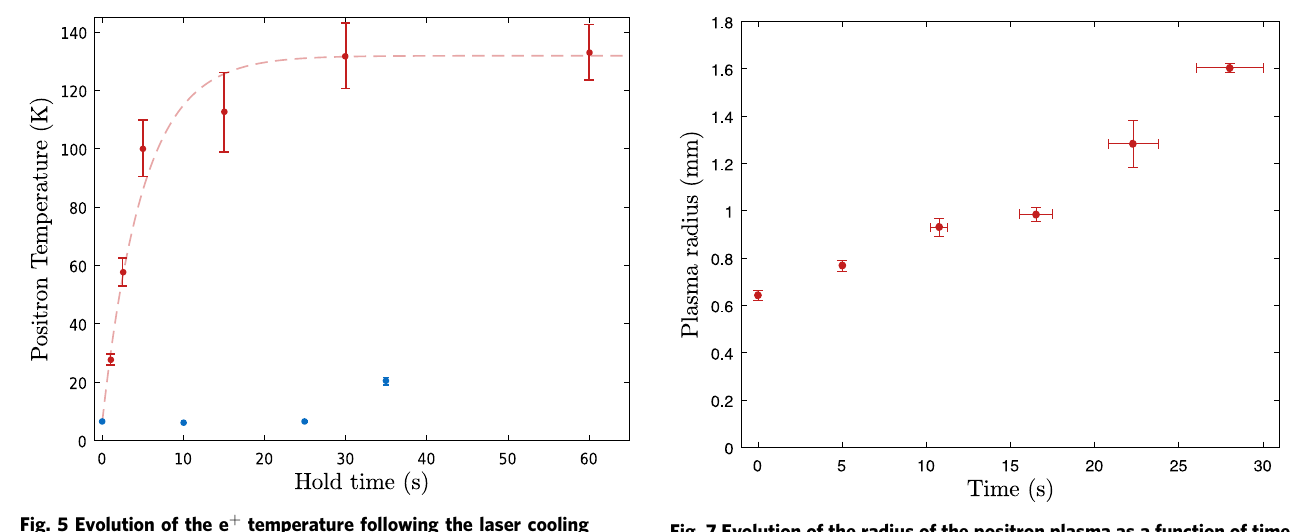
Fig. 7 Evolution of the radius of the positron plasma as a function of time during the laser cooling frequency sweep. The plasma was a mixture of 2.6 × 10 6 e + and ~4 – 5 × 10 5 Be + ions. Time zero is when the frequency sweep begins. The total sweep time we use to sympathetically cool the positrons to their lowest temperatures is 40 s. It is not possible to measure plasma radii greater than around 1.6 mm with our current MCP imaging diagnostic. The error corresponds to the standard error on the mean radius measured (vertical bars) and the laser-cooling time (horizontal).